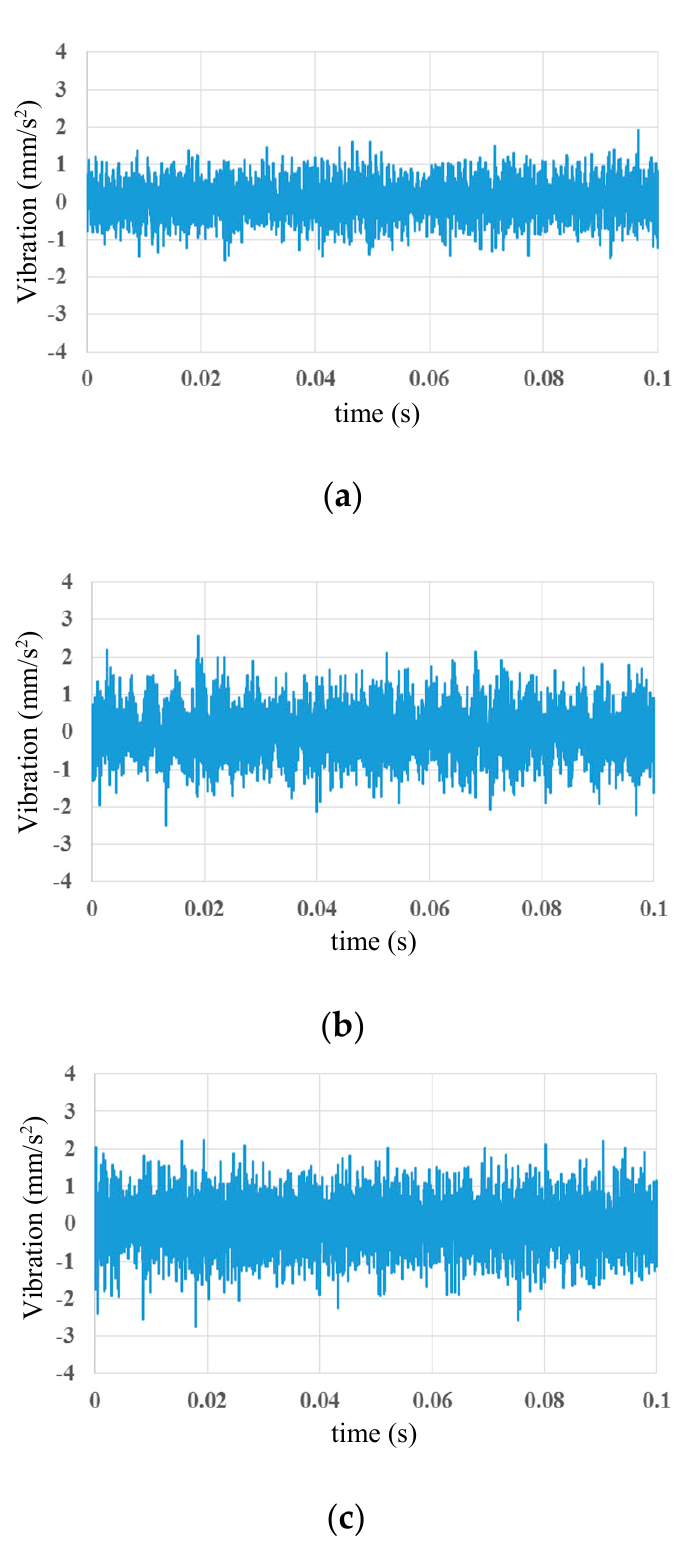
Figure6. Vibrationwaveformsat70%loadtorque: ( a )healthymotor; ( b )R-7.5%motor; ( c )Z-7.5%motor. Figure 6. Vibration waveforms at 70% load torque: ( a ) healthy motor; ( b ) R-7.5% motor; ( c ) Z-7.5% motor. Figure 7 shows FFT analyses of the vibration waveform emitted from the motor with radial − 1 demagnetization when the motor was running at a speed of 1200 min . Figure 8 shows those of the motor with axial demagnetization. It was found from these figures that the vibration at 70%